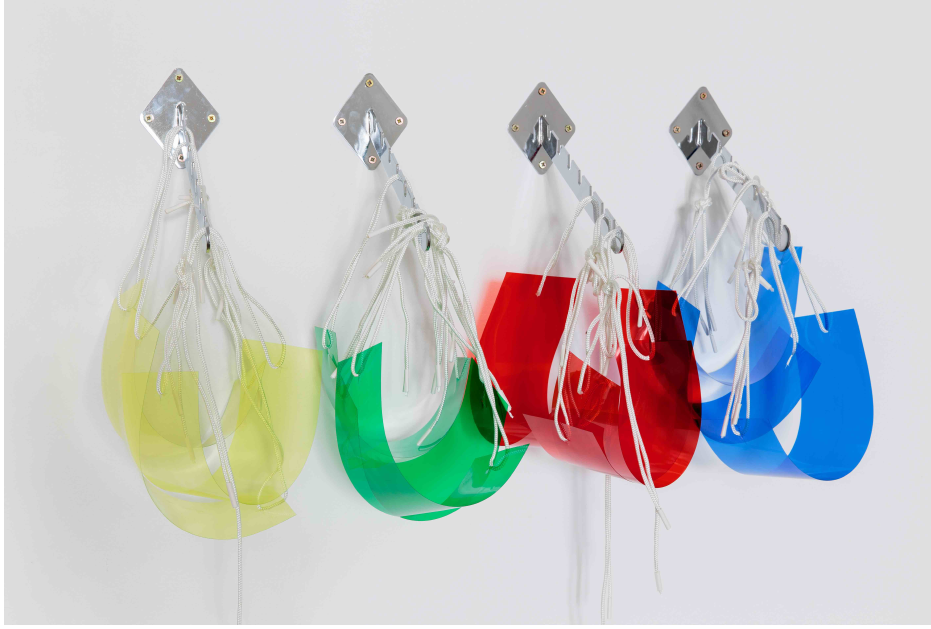
Figure 11: Sarah Kate Wilson, Visors , 2016. Coloured plastic, cord, clothing hang- ers, Dimensions